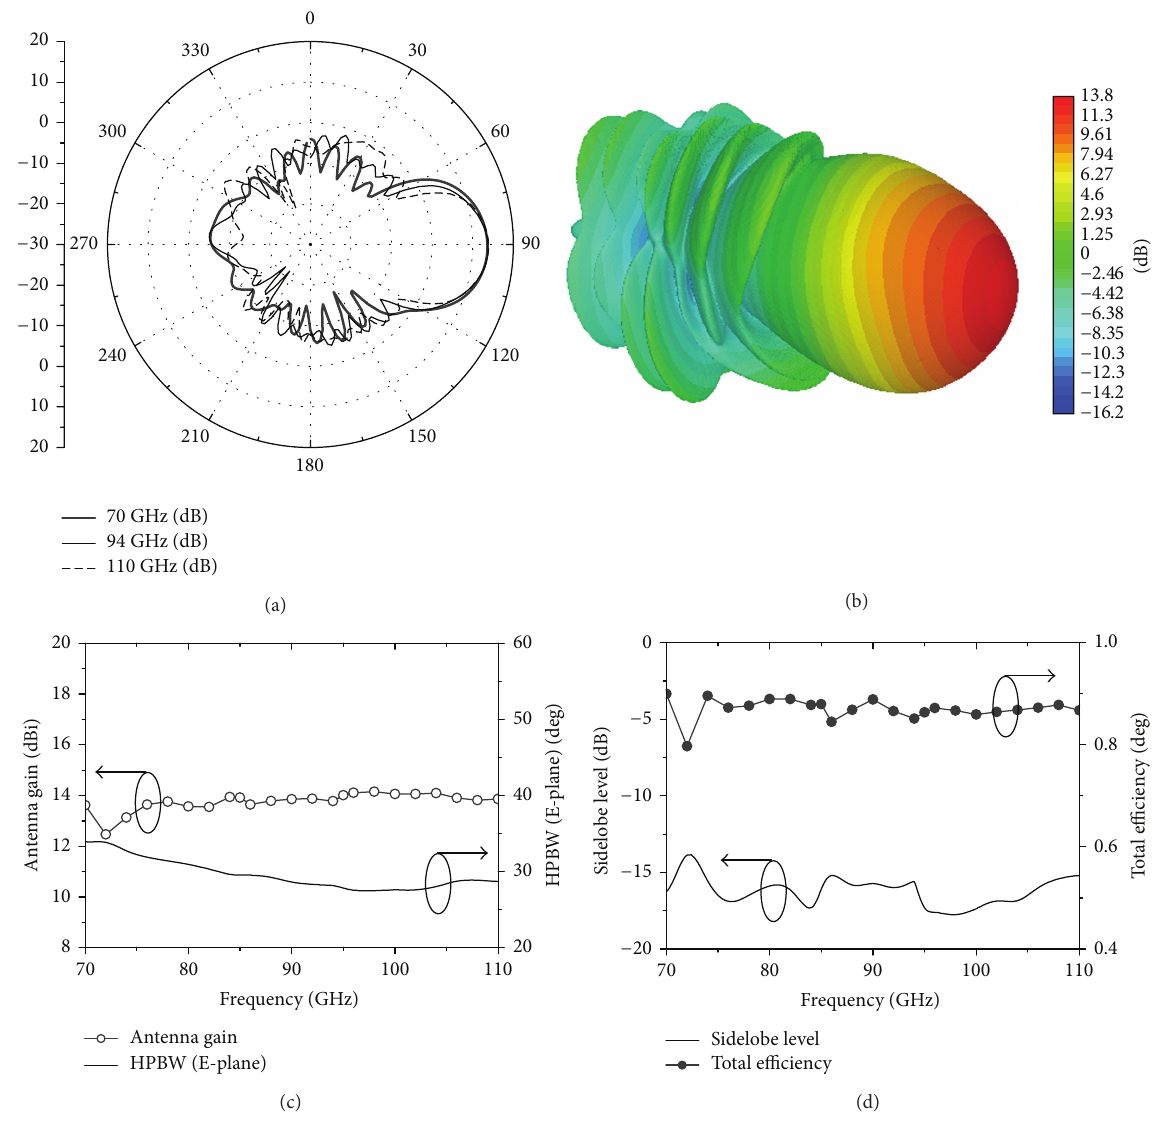
Figure 5: Simulated radiation performances: (a) E-plane radiation patterns at 70, 94, and 110GHz, (b) 3D radiation pattern at 94 GHz, (c) gain and HPBW of E-plane, and (d) sidelobe level and